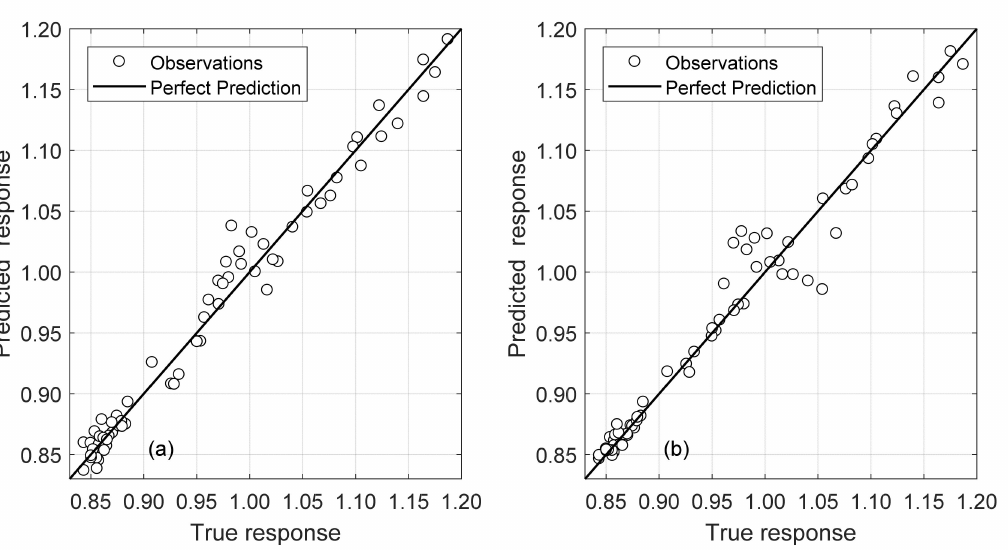
Figure 18. D12 Model Validation Predicted Vs Actual: ( a ) D12_ GPR_F1_F6; ( b ) D12_